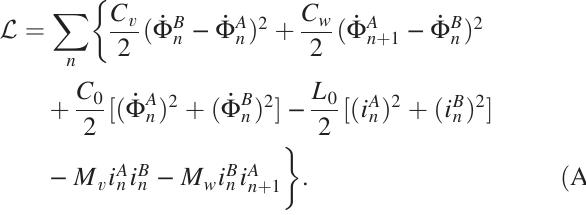
, C and mutual v w , M . The voltage and current at each resonator v w ; I A ; I B ( V B n n n n